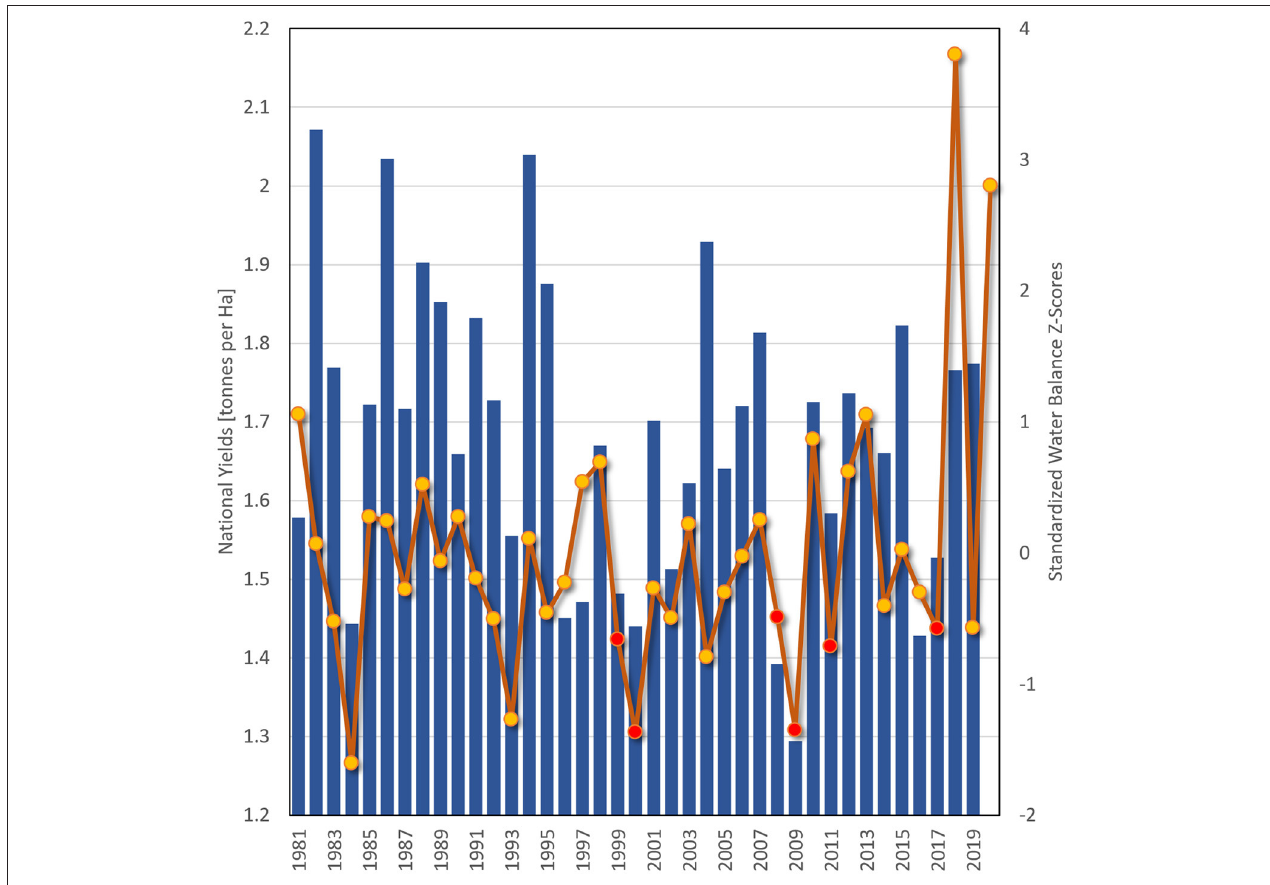
FIGURE 6 | Time-series of FAOSTAT national Kenyan maize yields (blue bars) and PWB Z-scores for key crop-growing counties (orange line with